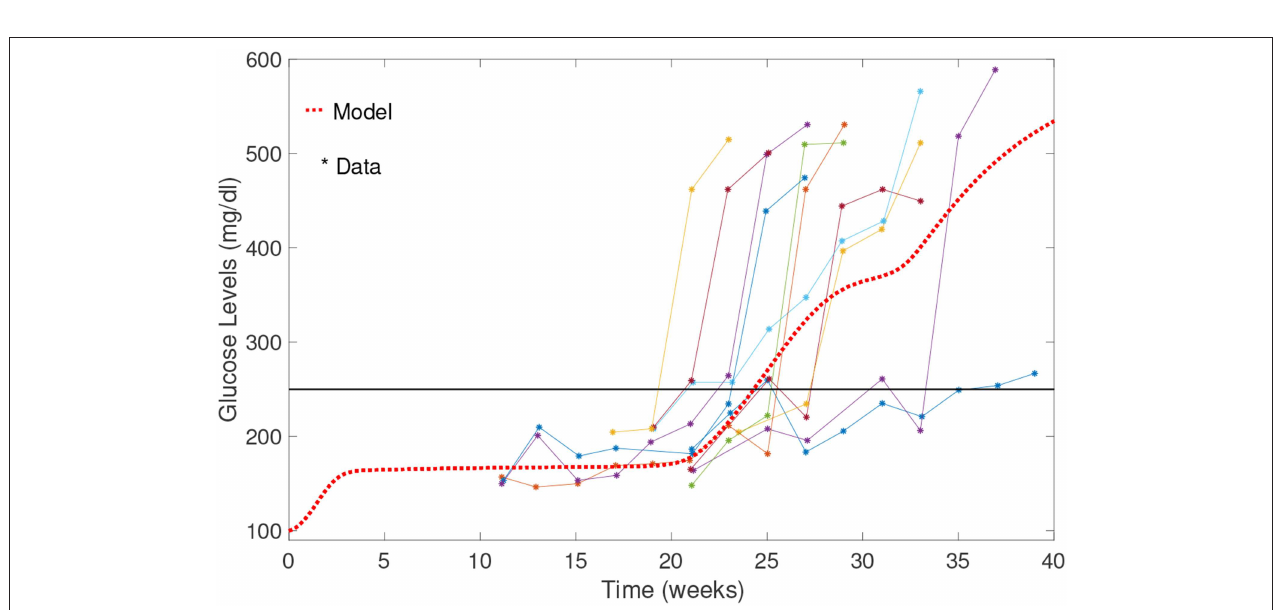
FIGURE 5 | Comparison of NOD model results with data from Li et al. (2010). Model results capture the average biological system response. Note the initial increase in blood glucose levels; glucose levels stabilize between weeks 3 and 20, and then rise relatively rapidly to above the 250 mg/dl threshold.